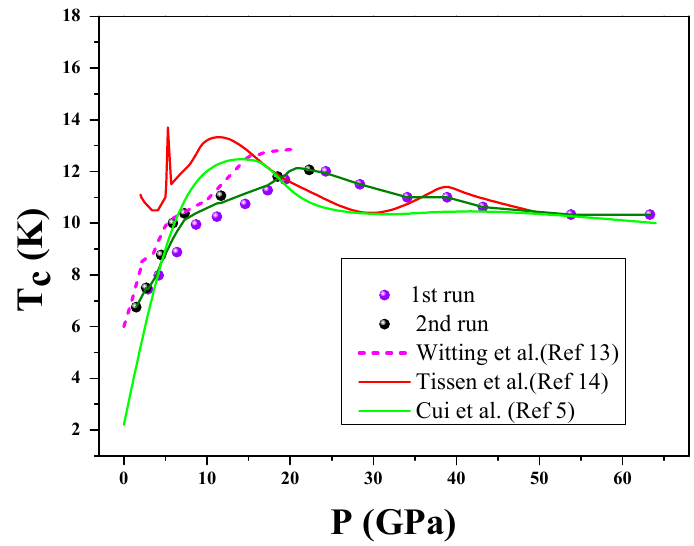
Figure 4. The evolution of superconducting transition temperature (T c ) as a function of pressure for La.